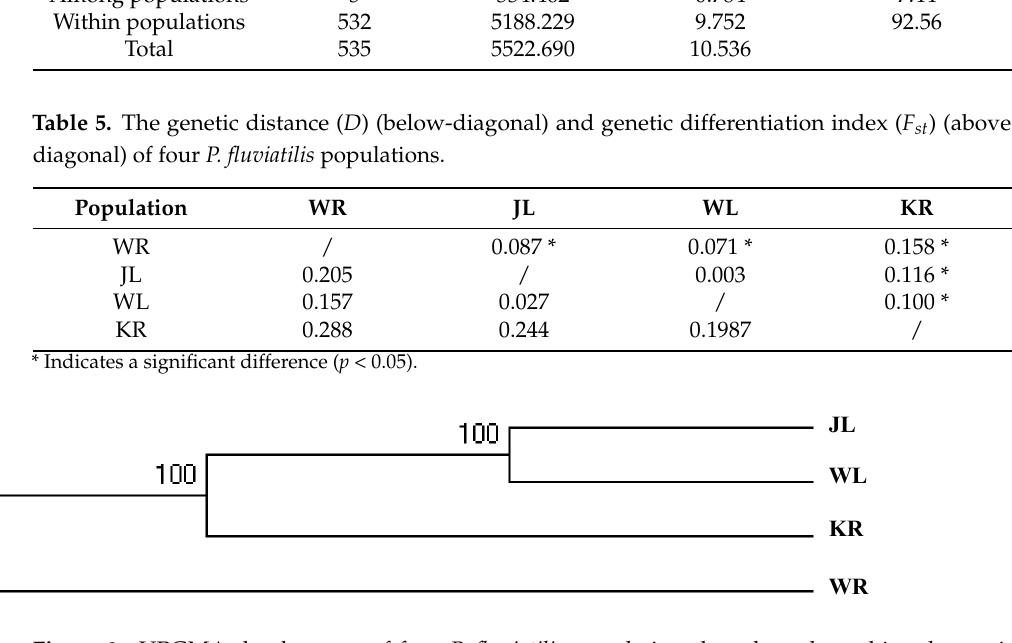
Figure 3. UPGMA dendrogram of four P. fluviatilis populations based on the unbiased genetic distance of N e .